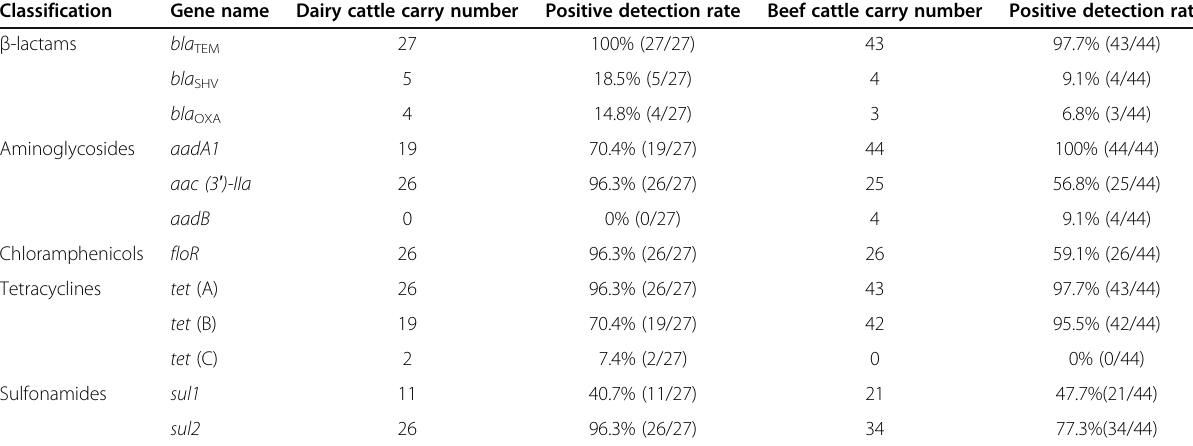
Table 2 E. coli resistance gene detection rate in dairy cattle and beef cattle Classification